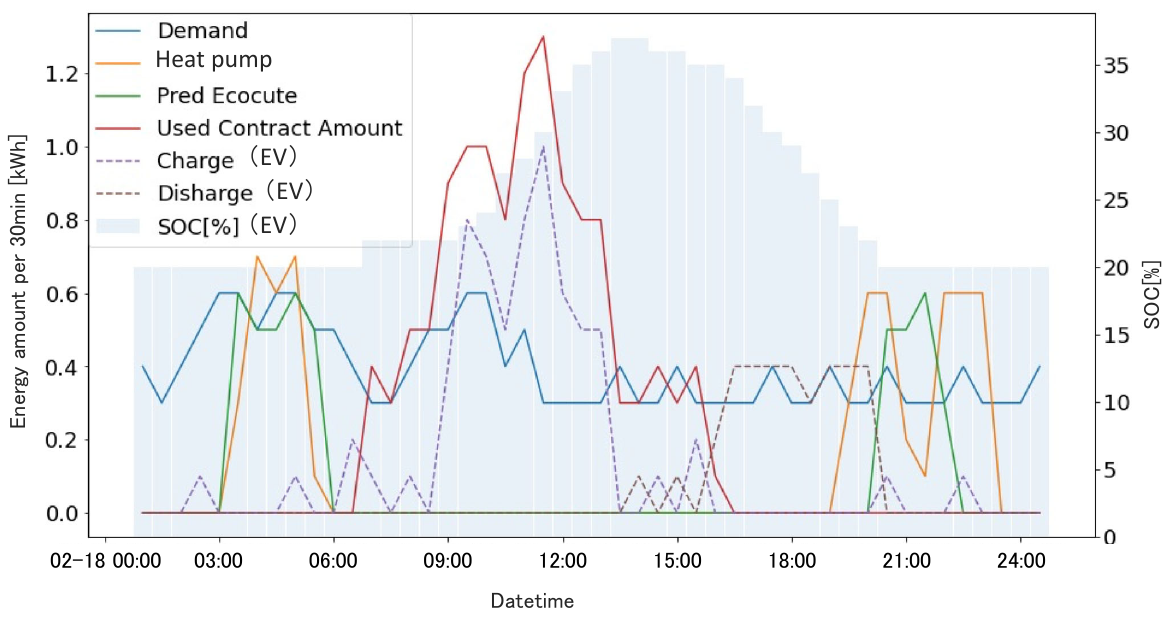
Figure 10. Electricity usage of HOME1 on one day during Phase 4 of the experiment.